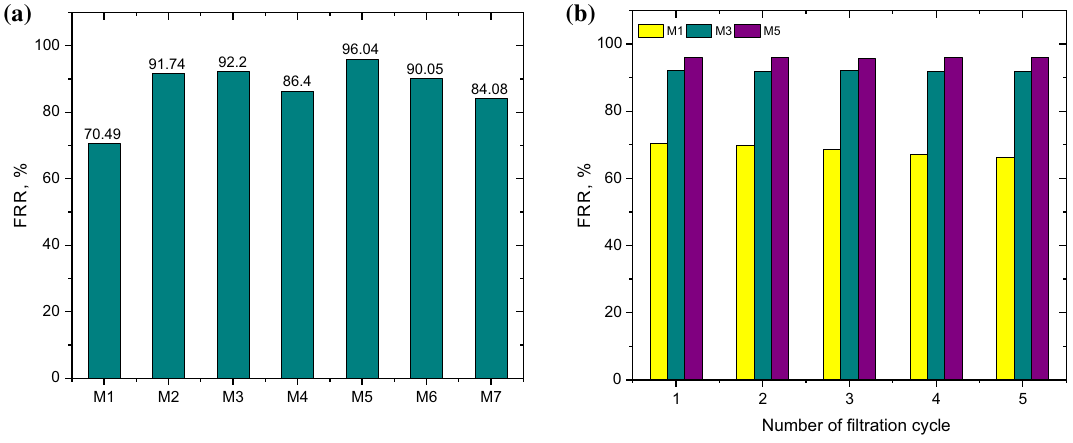
Fig. 7 FRR data of all the fabricated membrane ( a ) and FRR of M1, M3 and M5 during five repeated filtration cycles of milk solution/deionized water ( b )